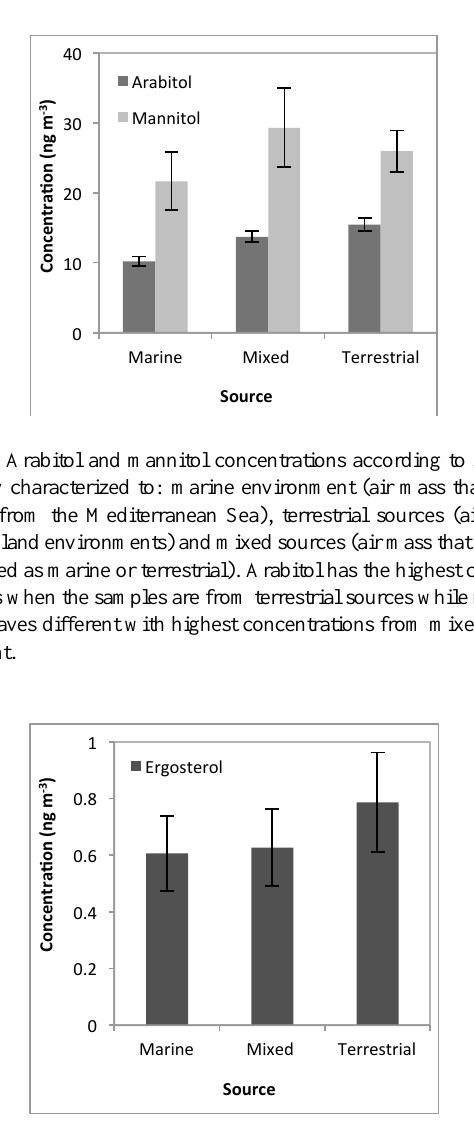
Fig. 10. Ergosterol concentrations according to source, broadly characterized to: marine environment, terrestrial sources, and mixed sources. Ergosterol has the highest concentrations when the samples are from terrestrial sources.